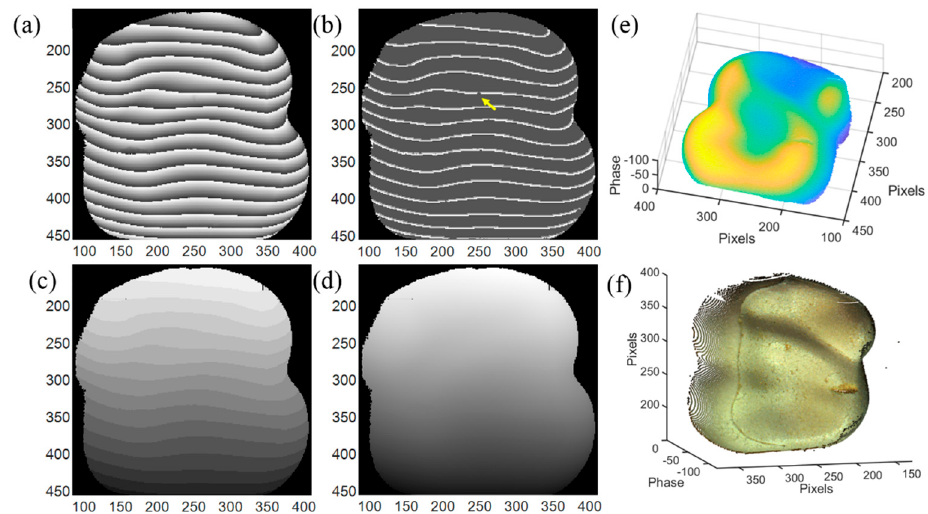
Figure 8. Phase unwrapping and 3D reconstruction of a tooth model. ( a ) Input wrapped phase data, ( b ) output phase feature map, ( c ) output phase feature map with assigned integer to each segment, ( d ) unwrapped phase, ( e ) 3D construction image of the target, and ( f ) 3D image of the target with color information.